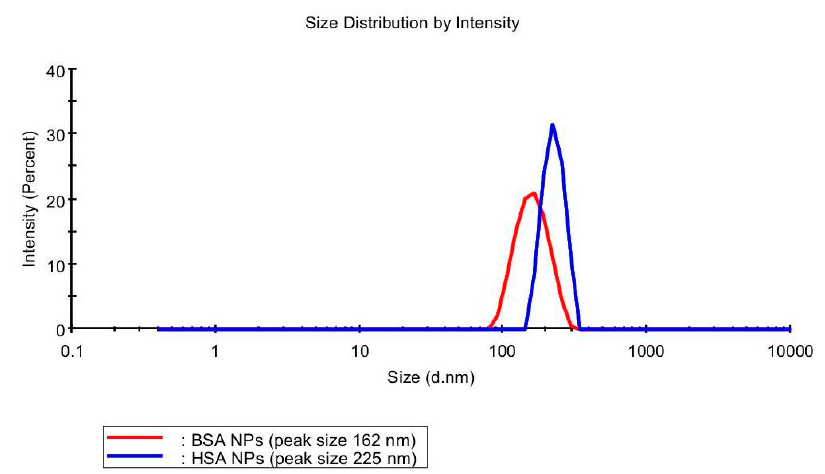
Figure 4. Exemplar size distributions of BSA and HSA nanoparticles measured by DLS.